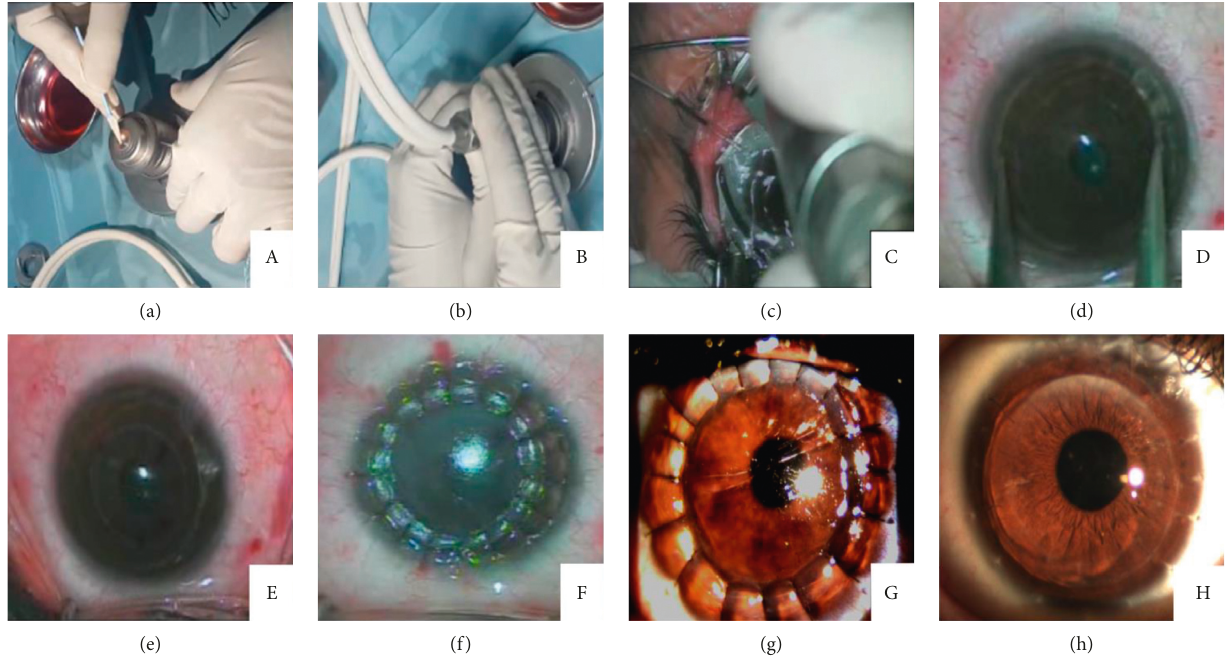
Figure 1: (a) Removal of epithelium from the graft using microsponge, (b) cutting the graft using 300 μ microkeratome head, (c) preparation of recipient cornea using 200 μ microkeratome head, (d) measuring the diameter of residual recipient bed using a caliper, (e) recipient stromal bed after incomplete full thickness trephination using 6.5mm suction trephine, (f) suturing of the donor graft using 16 interrupted nylon 10-0, (g) posterior stromal striations in case no. 5 at early postoperative period, and (h) complete disappearance of posterior stromal striation and a clear cornea of the same patient in (g), one year after